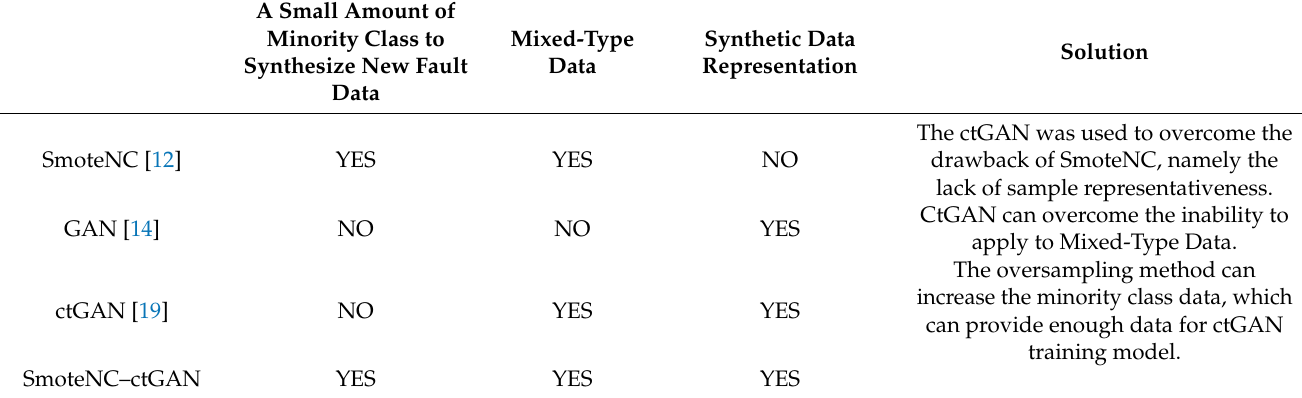
Table 1. Analysis of previous